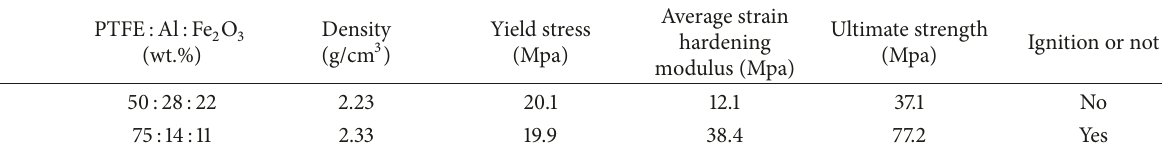
Table 1: Parameters of PTFE/Al/Fe 2 O 3 reactive material.